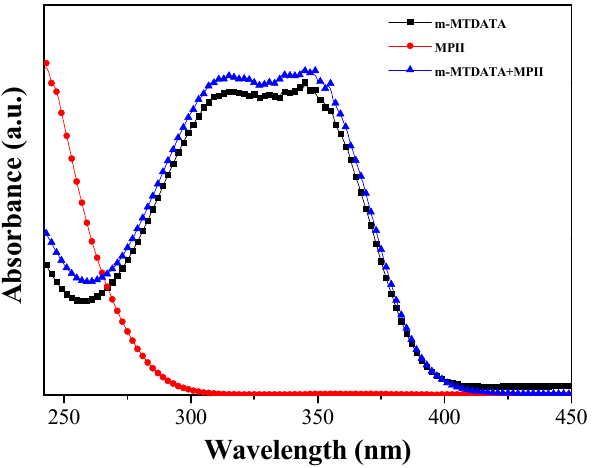
Figure 4. UV–visible absorption spectra of MPII, m-MTDATA, and their mixture in chloroform. A possible mechanism for triiodide formation can be explained by chemical reactions (1)–(4): m-MTDATA can absorb near UV and blue regions of visible light and can then be excited, as expressed in reaction (1). The excited m-MTDATA reacts with the oxygen mol-